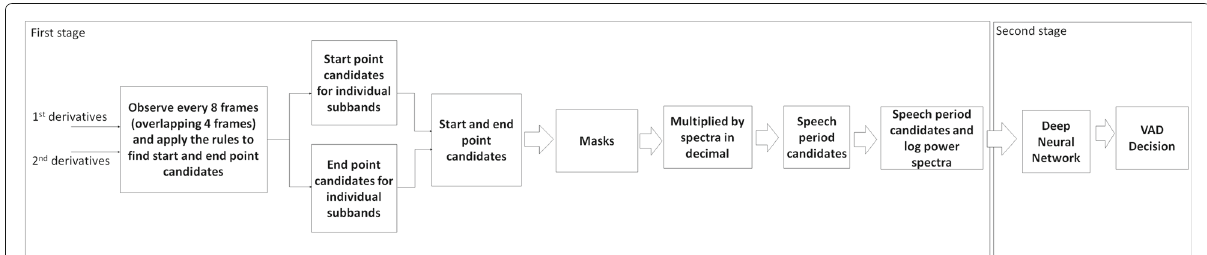
Fig. 2 Block diagram of the proposed method